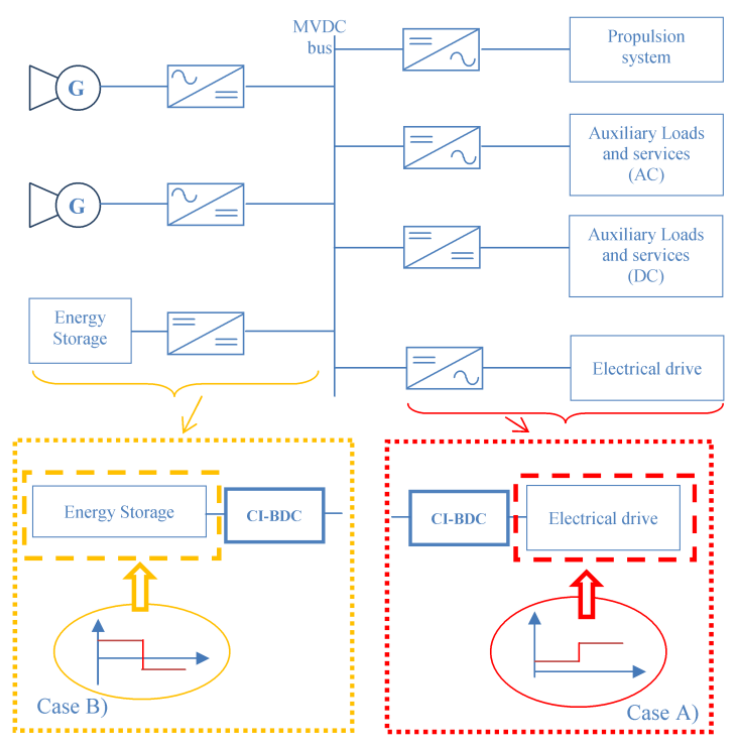
Figure 9. The medium voltage direct current (MVDC) ship electrical system under study.